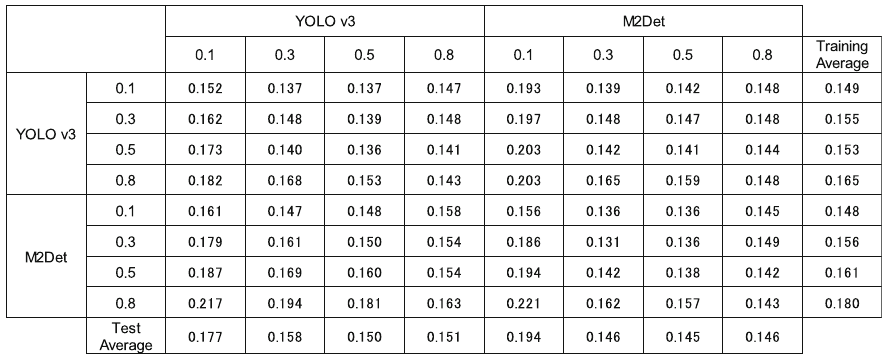
Table 3 The 90% value of absolute error with Ω BV using different object detection algorithm and